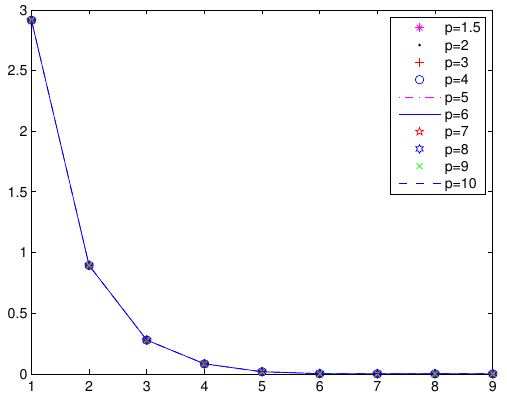
Figure 2. Numerical results for Example 1 by the STRM method. The x -axis represents the iteration (cid:107) F ( x , y ) (cid:107) 2 step; the y -axis represents θ ( x , y ) = 1 2